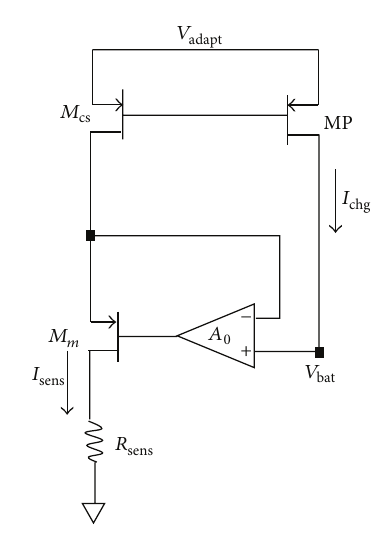
Figure 8: Current sense